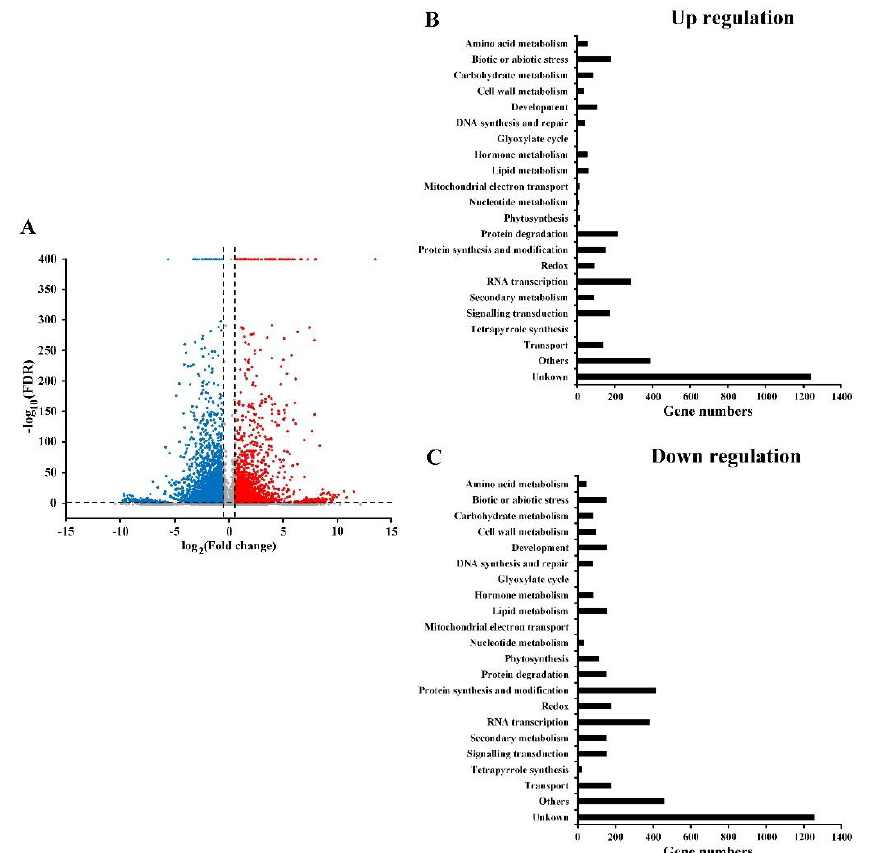
Figure 2. Volcano plots and Gene Ontology (GO) classification of differentially expressed genes in 10 μM TIBA treatment compared with submergence treatment. ( A ) Volcano plots of differentially expressed genes between between SUB and SUB + TIBA treatment. The log2 fold change (FC) of each gene on x-axis and log10 false discovery rate (FDR) of each gene on y-axis. The log2 fold change ≥ 0.584 (up-regulated genes) and ≤−0.584 (down-regulated genes) and FDR less than 0.01 were considered as significantly differentially expressed gene. ( B ) GO classification of differentially expressed genes in upregulation. The filter condition was fold change ≥ 1.5 and FDR less than 0.01. ( C ) GO classification of the differentially expressed genes in downregulation. The filter condition was fold change ≤ 0.66 and FDR less than 0.01. Table S3 presents the complete list of differentially expressed genes in GO classification.